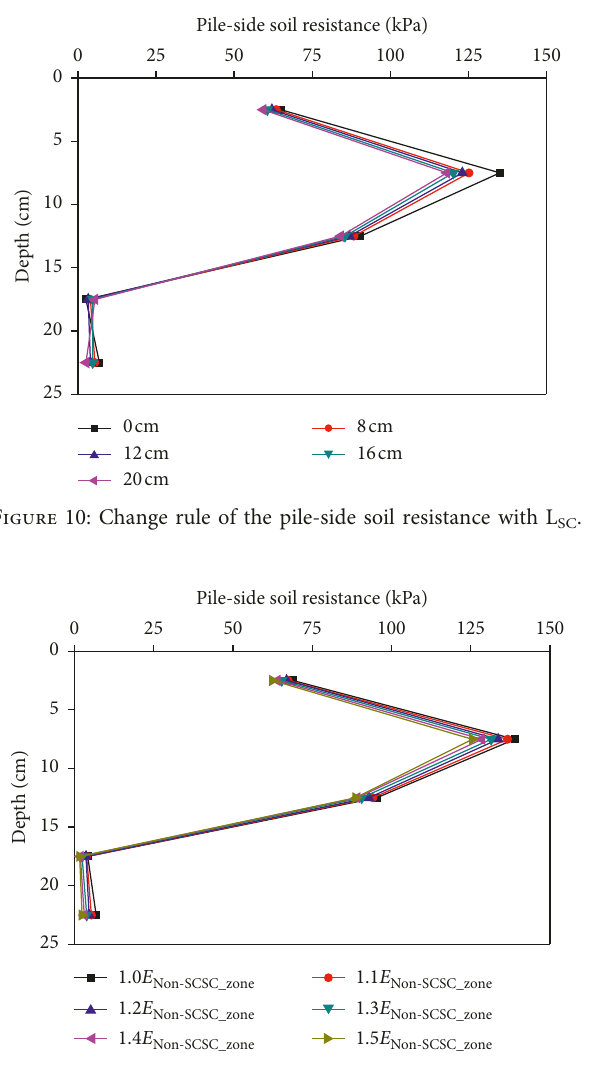
Figure 11: Change rule of the pile-side soil resistance with E SCSC_zone